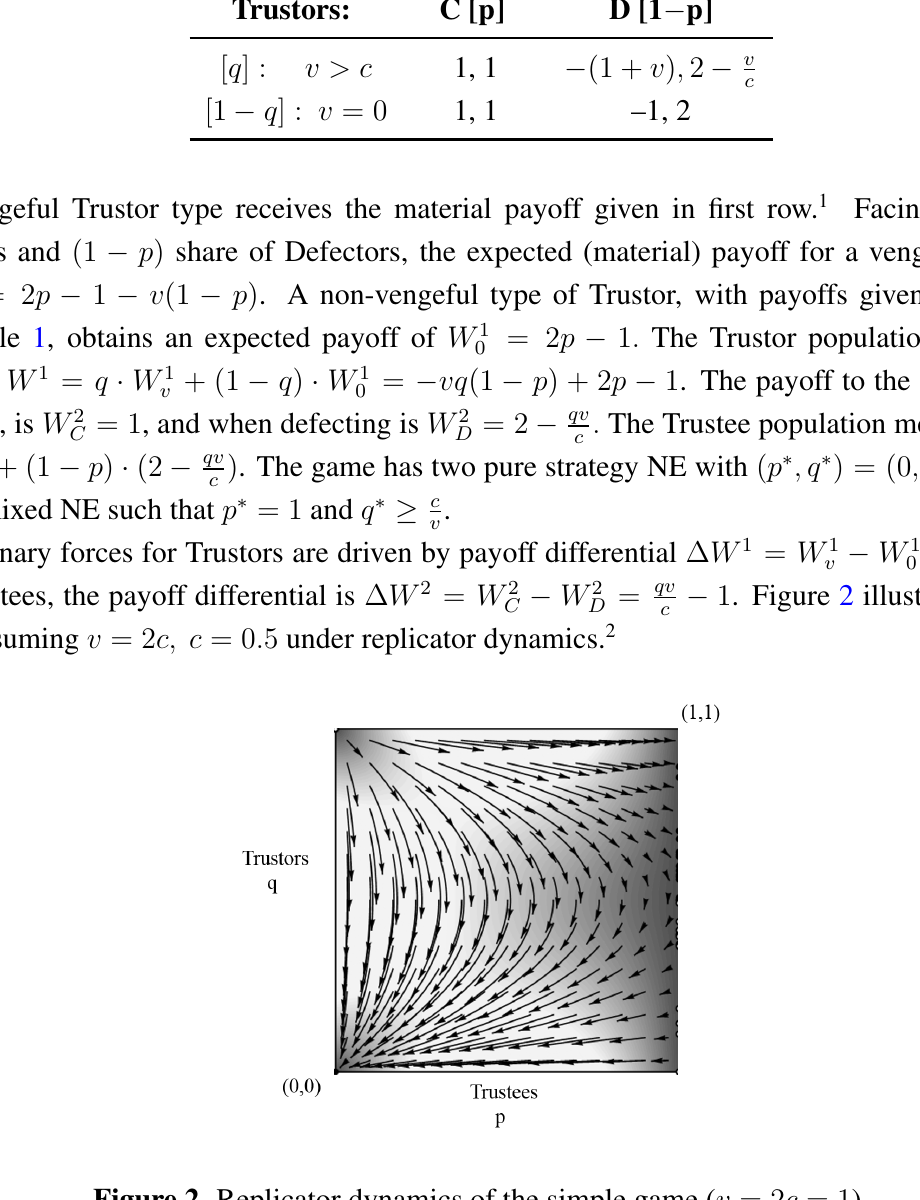
Figure 2. Replicator dynamics of the simple game ( v = 2 c = 1